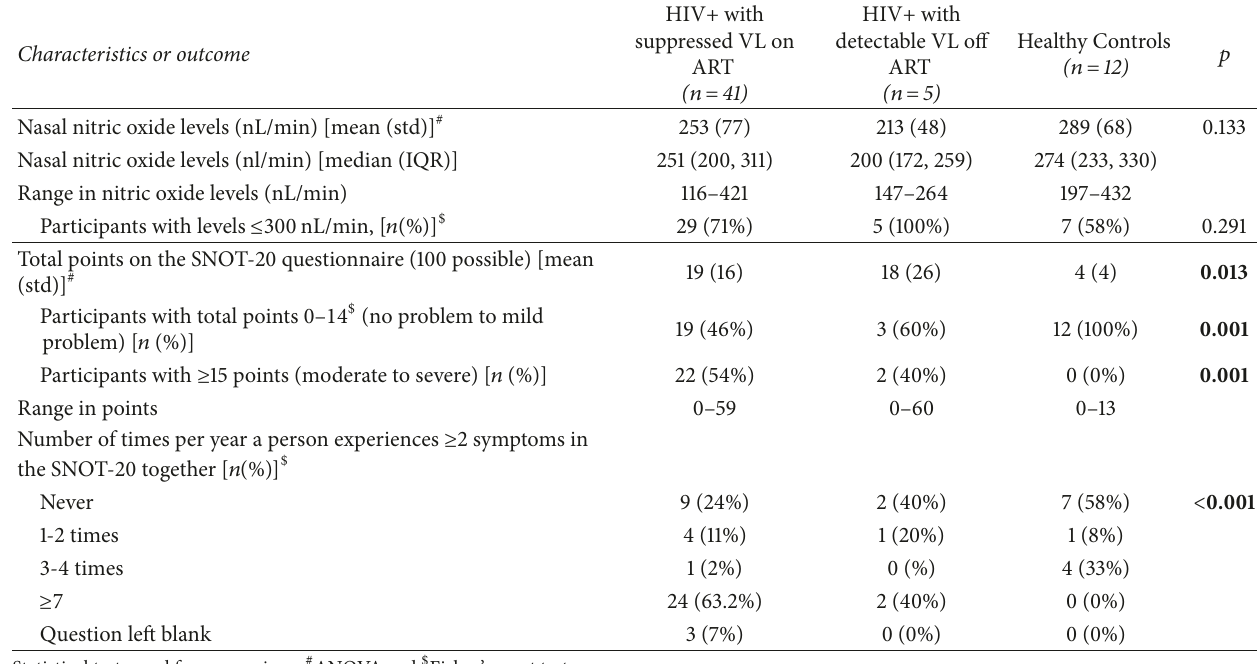
Table 2: Nasal nitric oxide levels and responses to items on the impact of Sinonasal Outcomes Test-20 (SNOT-20) questionnaire.